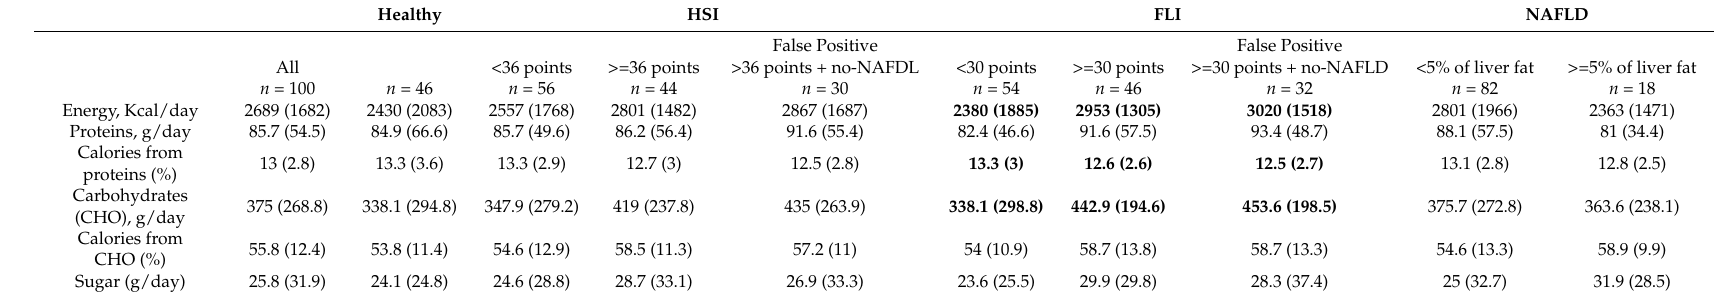
Table 3. Daily dietary information in the complete sample and according to the Indexes classification, median